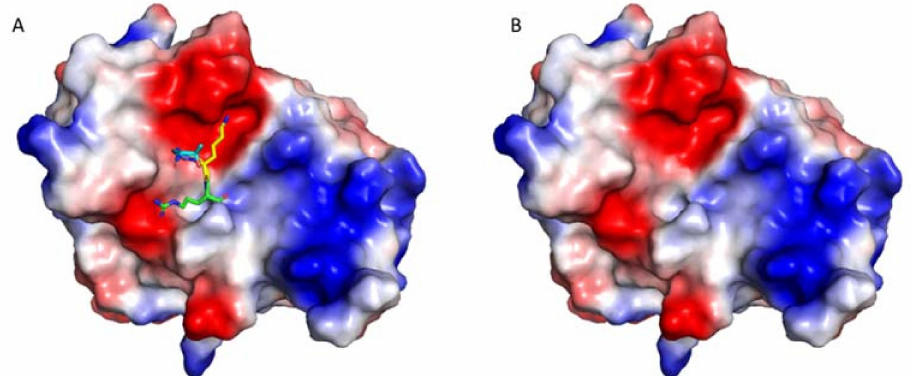
Figure 3. The protease active site is negatively charged. The structures of eZiPro (PDB ID 5GJ4) with ( A ) and without ( B ) TGKR sequence of NS2B are shown to understand the surface charges. The TGKR residues are shown in different color. The surface charge figure was made using PyMOL (www.pymol.org (accessed on 3 August 2018)). Surface areas with positive charge, negative charge, and no charge are shown in blue, red, and white, respectively. The substrate-binding site is negative charged, suggesting the challenges of developing small molecule inhibitors, which prefer interacting with a hydrophobic